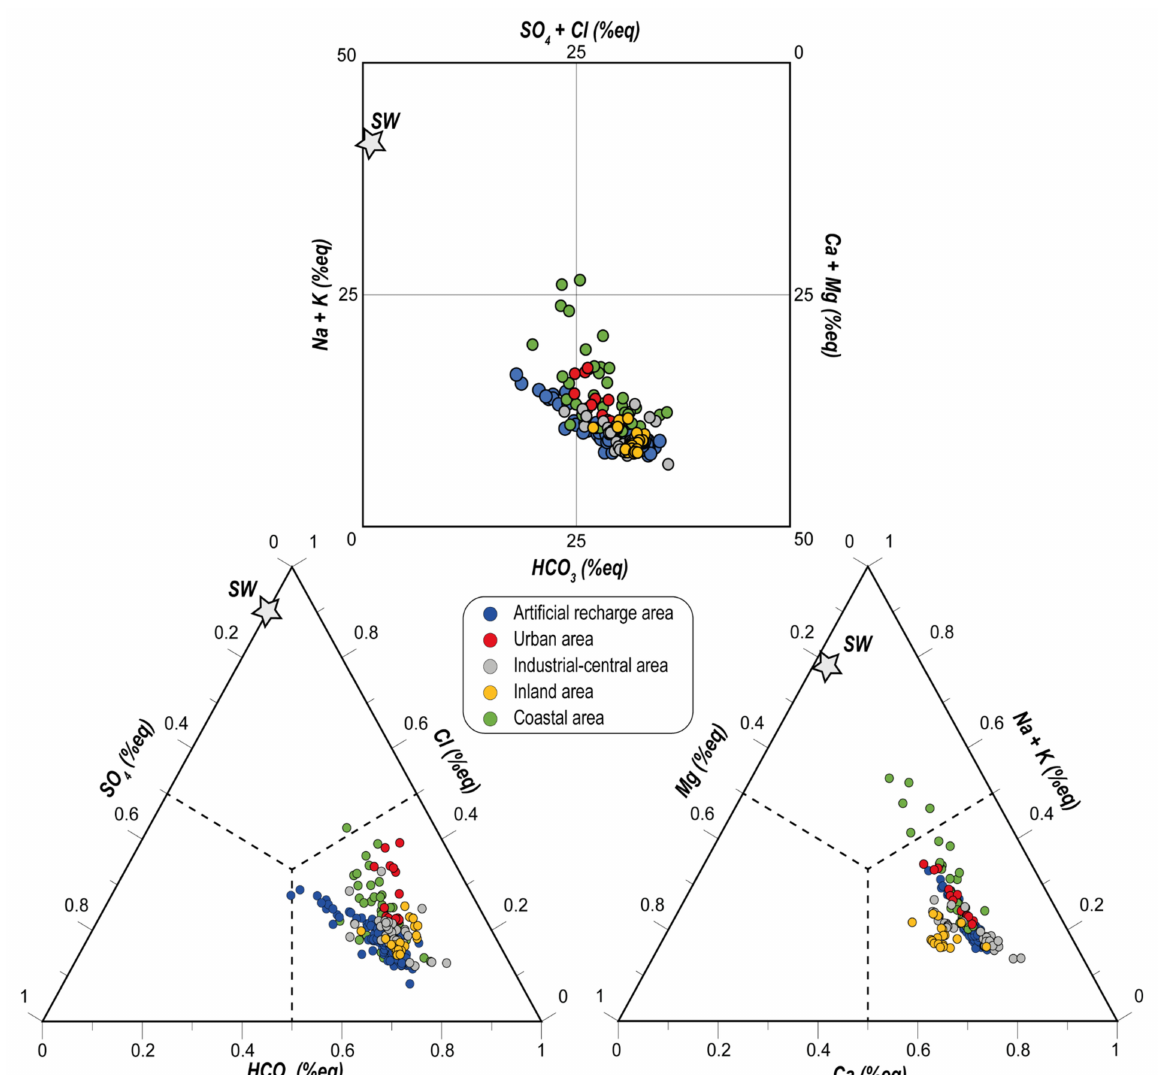
Figure 2. Langelier-Ludwig diagram and Cl-SO 4 -HCO 3 and (Na+K)-Ca-Mg triangular diagram for the investigated samples. SW: